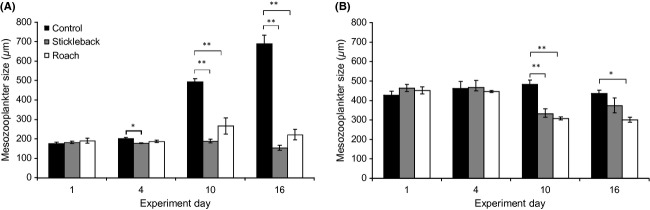
Mean weighted size of the average mesozooplankter (rotifers and crustaceans) in spring (A) and summer (B) experiments. Asterisks indicate significant differences (*P < 0.05, **P < 0.01) between treatments. Error bars are ± SE.